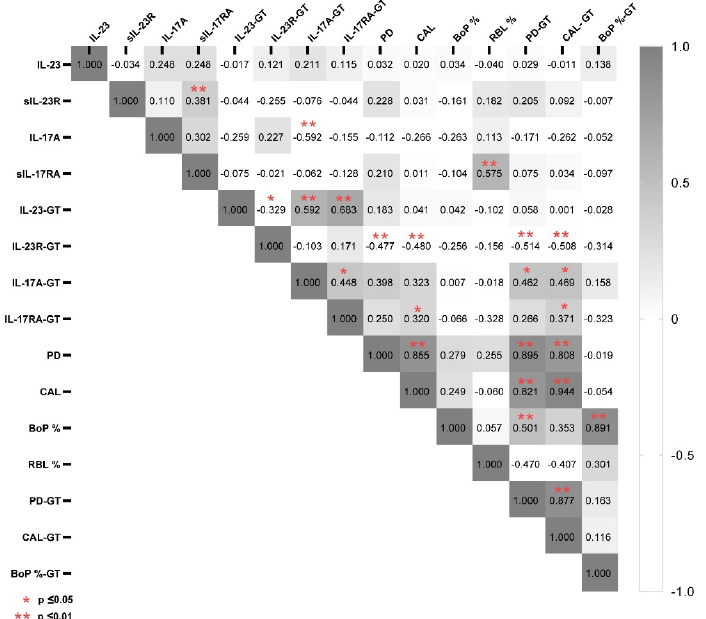
Figure 3. Correlation between the IL-23/IL-17A axis molecules and IL-23R IL-17RA receptors with clinical parameters in plasma and gingival tissue were analyzed using the Spearman correlation test. PD: probing depth, CAL: clinical attachment loss, BoP%: bleeding on probing percentage, RBL%: percentage of radiographic bone loss in plasma and (GT): gingival tissue values. * p ≤ 0.05, ** p ≤ 0.01.